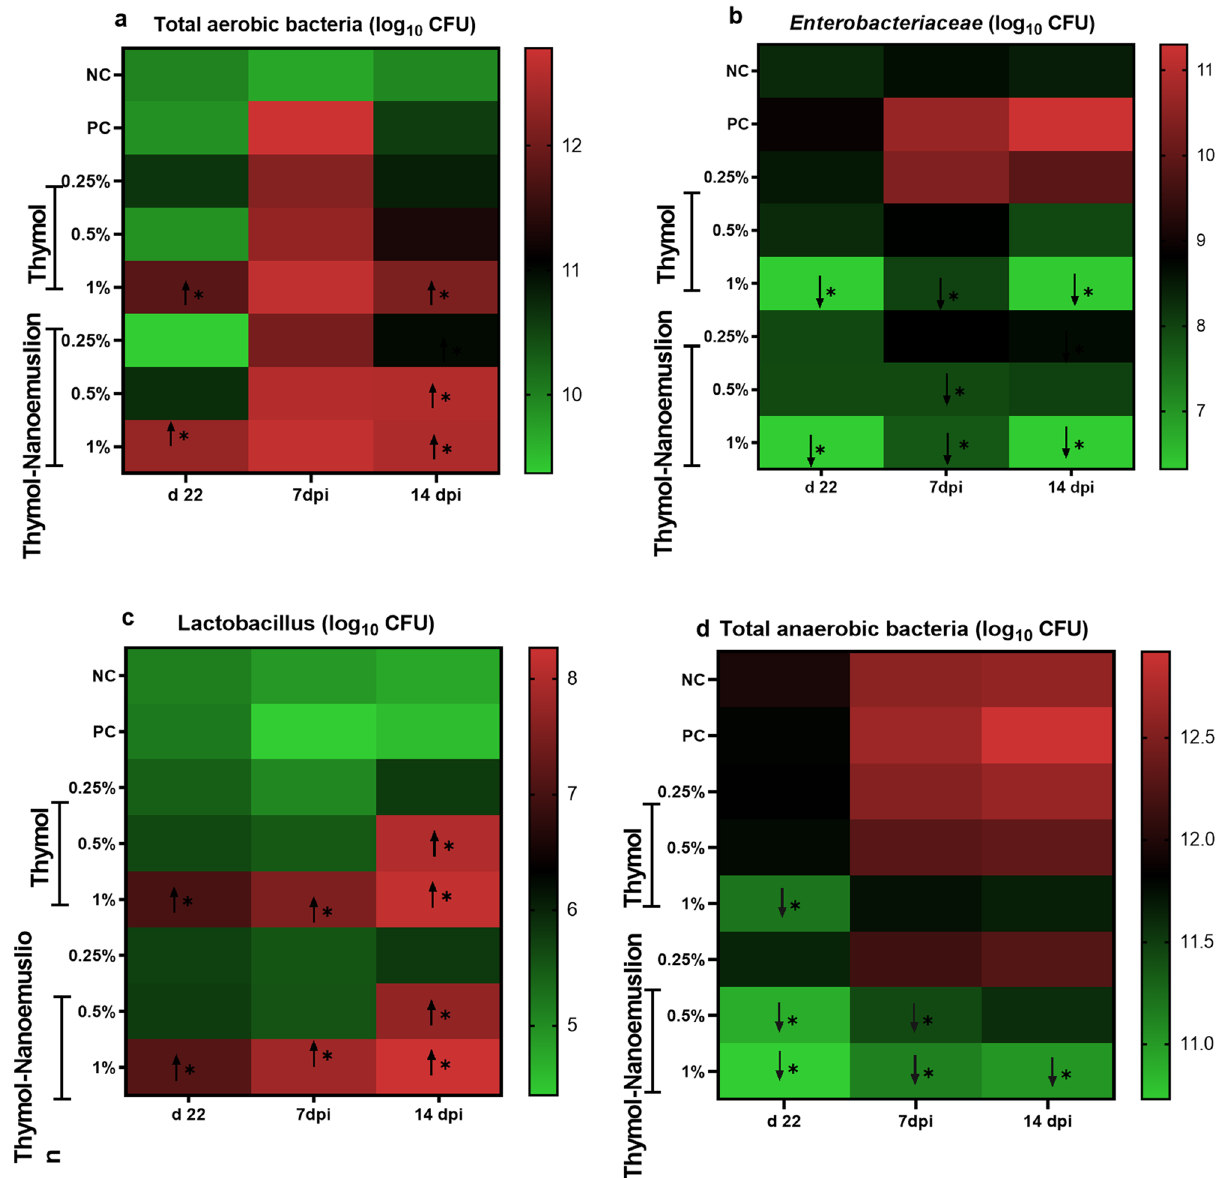
Figure 5. Heat map demonstrating the total aerobic bacterial ( a ), Enterobacteriaceae ( b ) and lactobacillus ( c ) total anaerobic bacterial ( d ) populations (log 10 CFU) in the cecum of broiler chickens preinfection, d 22 and 7 and 14 days postinfection (7 and 14 dpi) with S. Typhimurium in response to supplementation with different levels of thymol and thymol nanoemulsion. *Red and green squares corresponded to significant counts increased ( ↑ ) and decreased ( ↓ ) relative to the control groups ( p < 0.05). Other squares with no (*) denoted no significant changes in the bacterial counts among the experimental groups. At d 22 preinfection: NC (negative control) = birds fed basal diet, thymol 0.25, 0.5 and 1% = birds fed basal diet supplemented with 0.25, 0.5 and 1% thymol, thymol nanoemulsion 0.25, 0.5 and 1% = birds fed basal diet supplemented with 0.25, 0.5 and 1% thymol nanoemulsion. At 7 and 14 dpi: NC (negative control): birds fed basal diet; PC (positive control): birds fed basal diet and challenged with S . Typhimurium at d 23 of age; thymol 0.25, 0.5 and 1%: birds fed basal diet supplemented with 0.25, 0.5 and 1% thymol; thymol nanoemulsion 0.25, 0.5 and 1%: birds fed basal diet supplemented with 0.25, 0.5 and 1% thymol nanoemulsion. All groups except NC group were challenged with S . Typhimurium at d 23 of